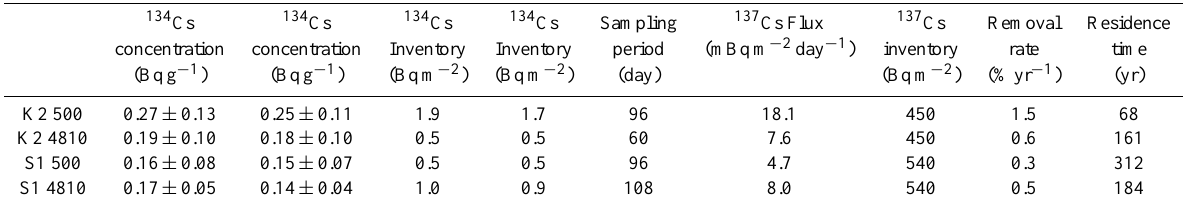
Table 3. Total radiocesium flux, average radiocesium concentration, suspected 137 Cs inventory (see text), and removal rate of 137 Cs from and residence time of 137 Cs at surface water.